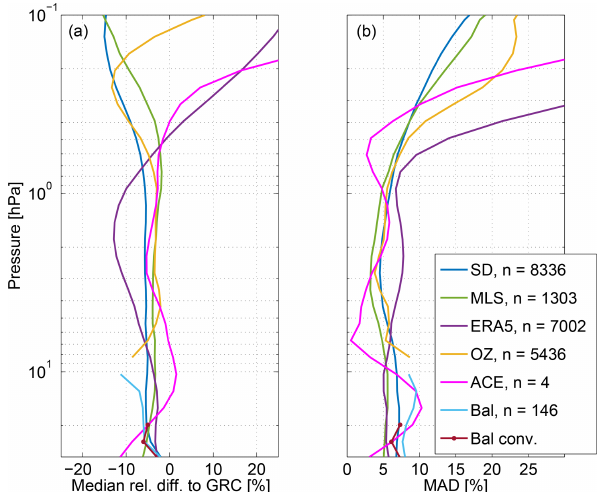
Figure 6. Median of the relative difference of SD-WACCM, MLS, ERA5, OZORAM, ACE and balloon-borne ozonesonde profiles and GROMOS-C ozone measurements at Ny-Ålesund (a) . Median ab- solute deviation of the relative difference profiles (b) . In the legend n indicates the number of coincident GROMOS-C